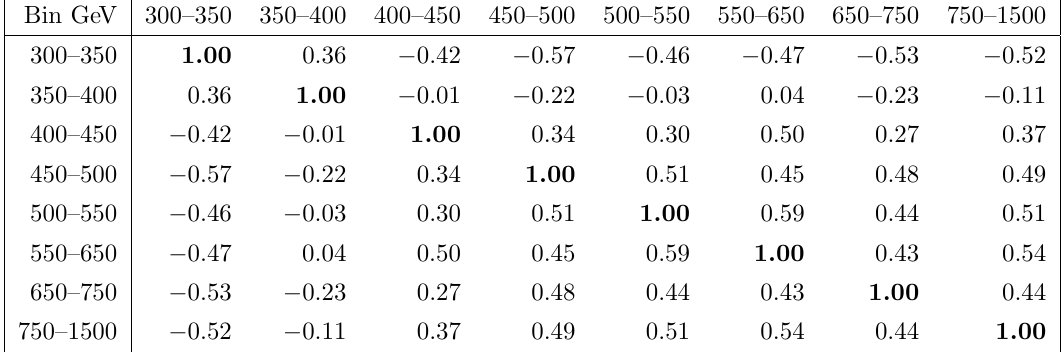
Table 5. Correlation matrix for the relative cross-section as a function of the hadronic top-quark p T , accounting for the statistical and systematic uncertainties in the boosted topology.